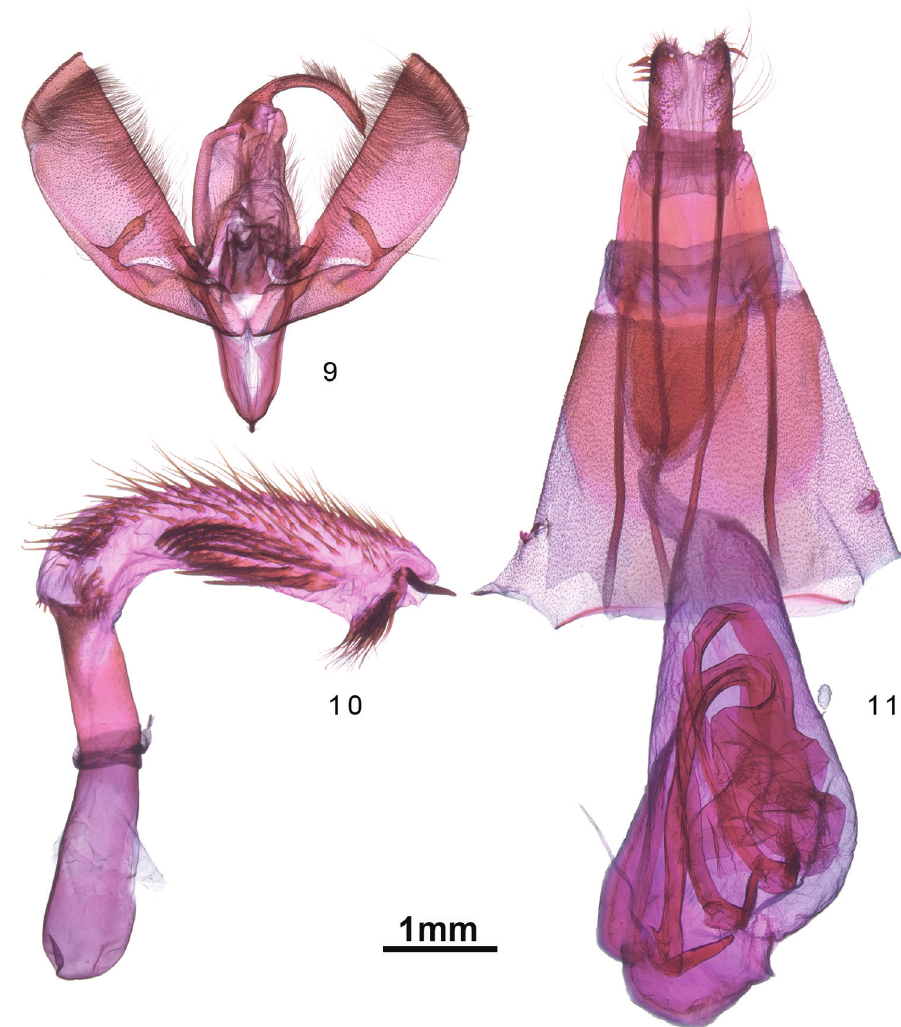
S. induta , S. rayata (Smith) and S. tenuistriga (McDunnough) is defined by absence of the stout foretibial spine, presence of a tiny, vestigial corpus bursae, and the origin of the ductus seminalis from the anterior appendix bursae. Sympistis eleaner exhibits all of these synapomorphies, placing it securely within the S. badistriga species-group. However, neither its barcode nor morphological features suggest a close relationship to any particular species, seemingly representing a distinct and likely relict eastern member within the group with a long, separate evolutionary history. This underscores the need for a phylogenetic framework for this very large, morphologically and eco- logically diverse